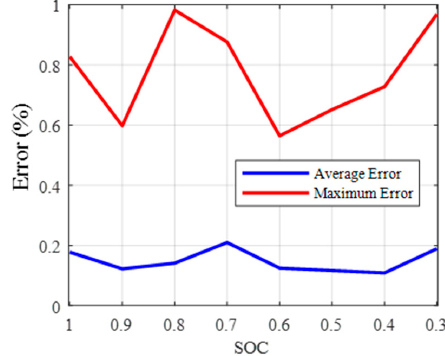
Figure 7. Average and maximum estimation error of different SOC ref .